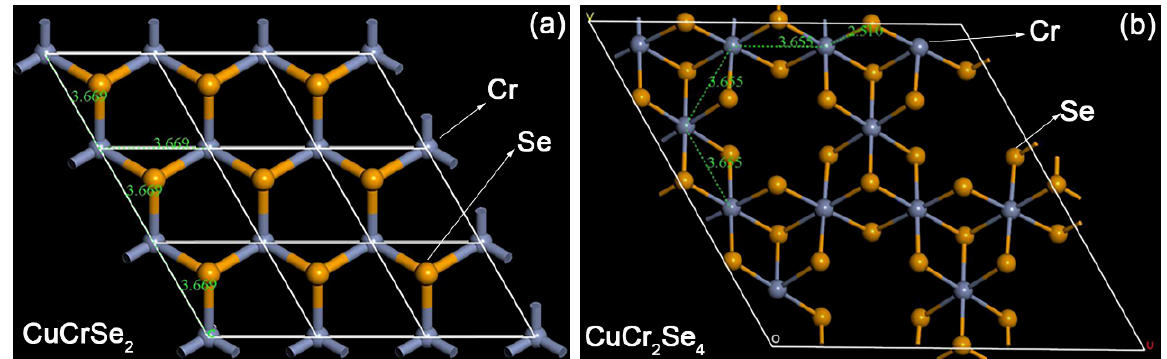
Figure 4. Atomic lattice structures of CuCrSe 2 ( a ) and CuCr 2 Se 4 ( b ) projected along [001]- and [111]-direction, respectively. To highlight the similarity between these two compounds, only Cr and Se atoms are drawn in this figure. One can see that Cr-Cr atoms in CuCrSe 2 form the triangle lattice, while those in CuCr 2 Se 4 forms a honeycomb-like one. The nearest Cr-Cr atomic distance in CuCrSe 2 is around 3.669 Å, which is quite close to that in CuCr 2 Se 4 (3.655 Å), which suggests the semi-coherent interface between CuCr 2 Se 4 and CuCrSe 2